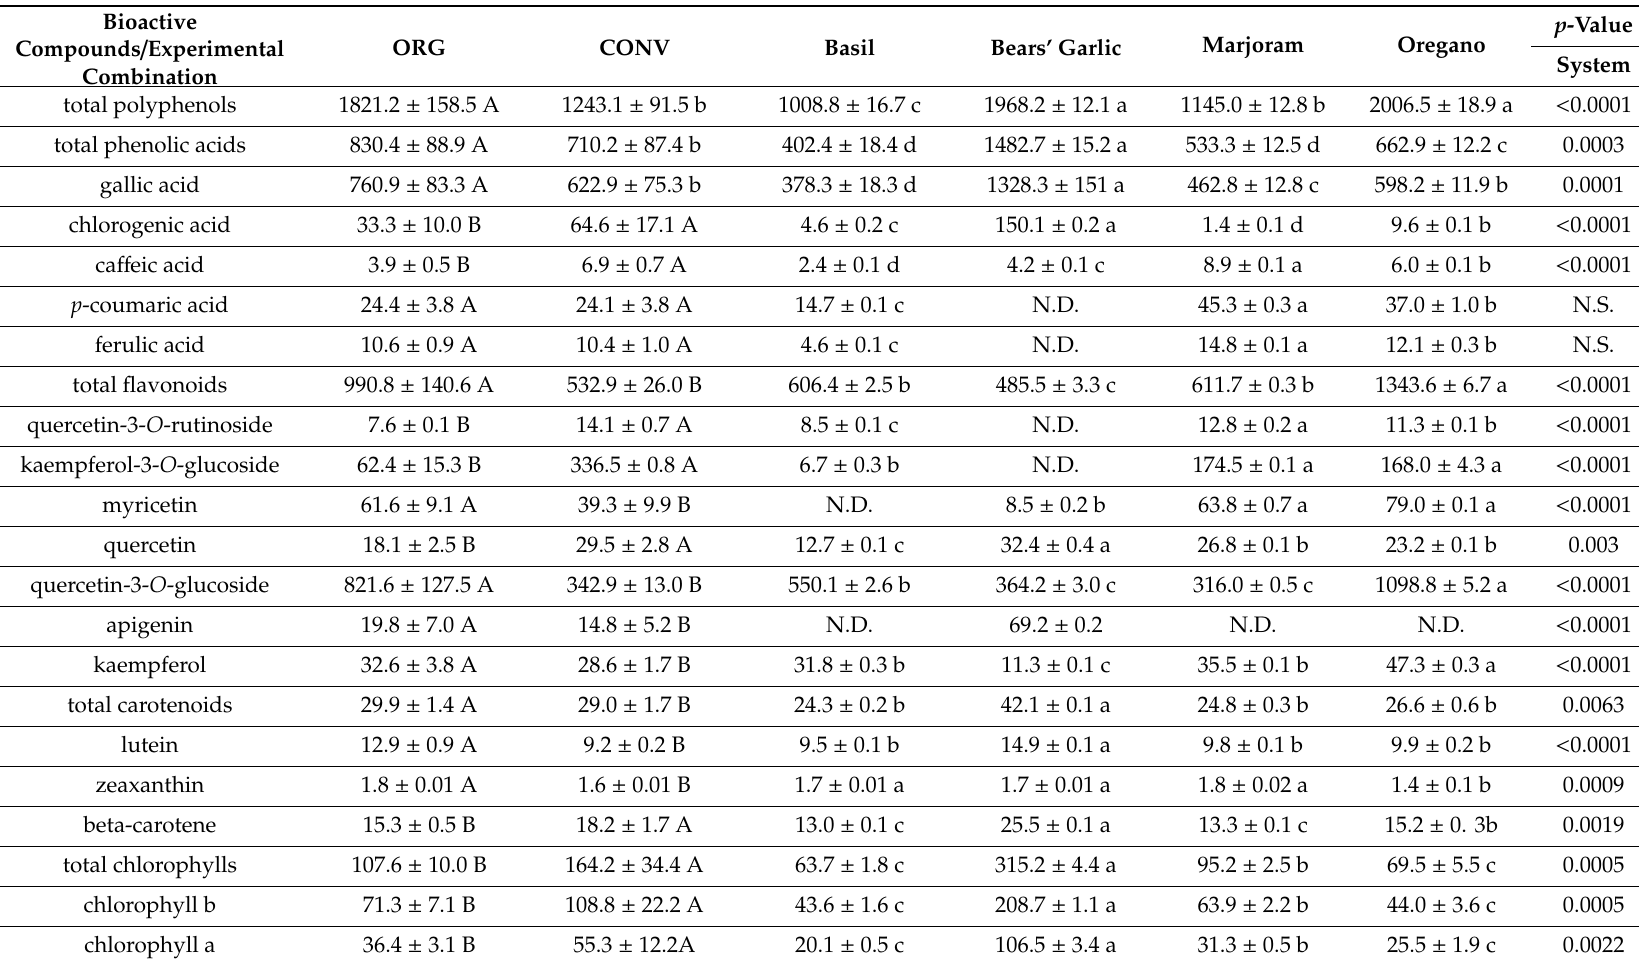
Table 2. The content of bioactive compounds (in mg 100 g − 1 of product) in selected spices from organic and conventional production in